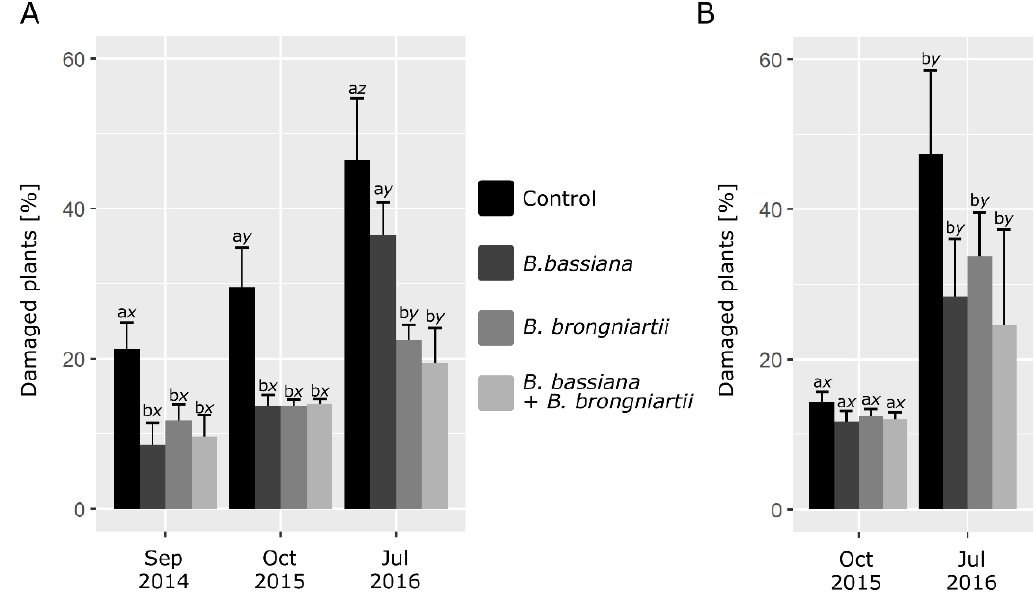
Figure 1. Effect of the application of formulated entomopathogenic fungi ( Beauveria bassiana and Beauveria brongniartii ) as a single inoculum or as mixture, on the number of damaged strawberry plants by grubs of M. melolontha . ( A ) trial NW (Nowa Wola) ( B ) trial BZ (Brzostówka). Means ± SD. Letters are showing the statistical differences between treatments within the same assessment period (a–c) and between periods within the same treatment ( x – z ) for p ≤ 0.05. Table 1. Efficacy of formulated products containing the entomopathogenic fungi ( Beauveria bassi- ana (BA) and Beauveria brongniartii (BR)) as a single inoculum or as mixture (BA + BR), on reducing the damage to strawberry plants by grubs of M. melolontha .